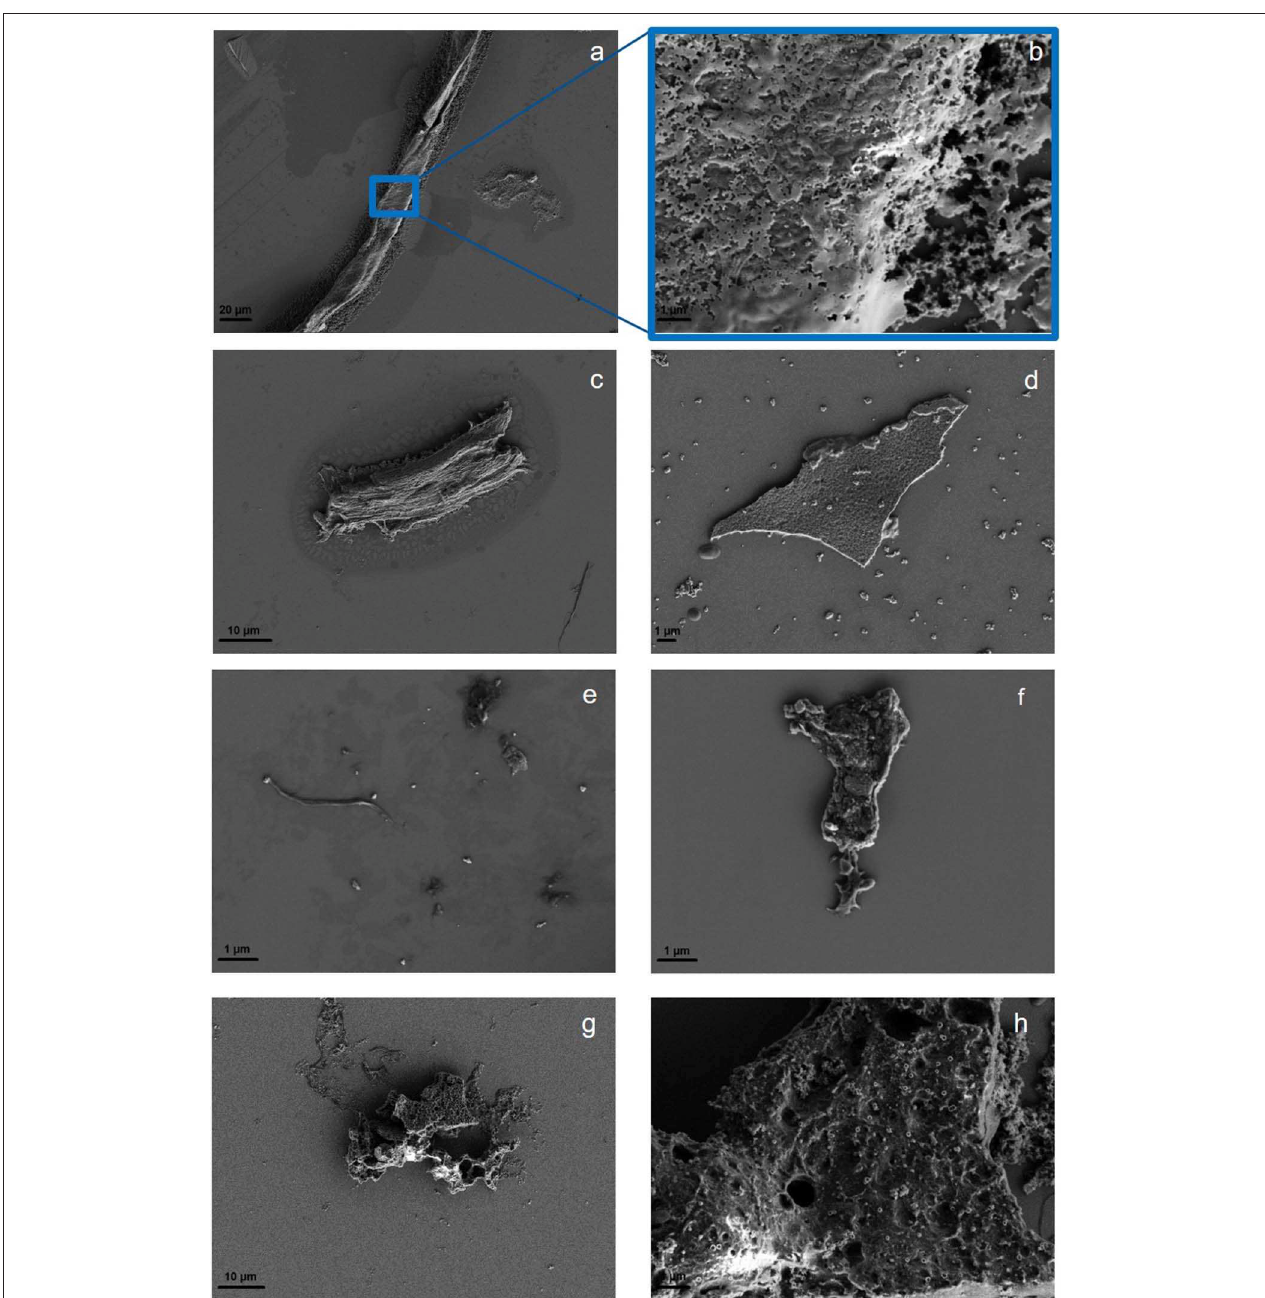
FIGURE 3 | Surface morphology of PS showing a wide range of particle shapes: fiber (a) , with a closeup of the fiber surface (b) , irregular fragment (c) , and spheres and film (d) . PET fragments, fibers and spheres are shown in (e) with a closeup of the surface of a fragment (f) . Typical PLA fragment (g) with a closeup of the surface of a fragment (h) . More SEM images are available in SI Figures 6 , 7